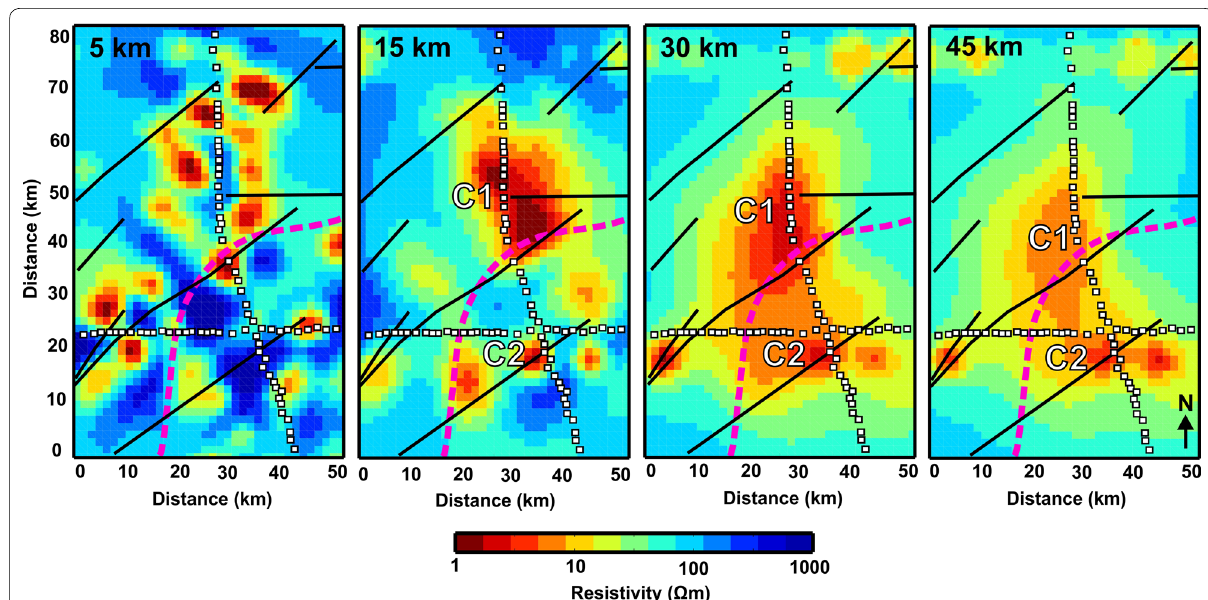
Fig. 6 Resistivity depth sections for different depths (5, 15, 30, 45 km), with projected surface trace of the faults (black solid lines), boundary of the tectonic blocks (pink broken lines), volcanic centers (red triangles) and station locations (white